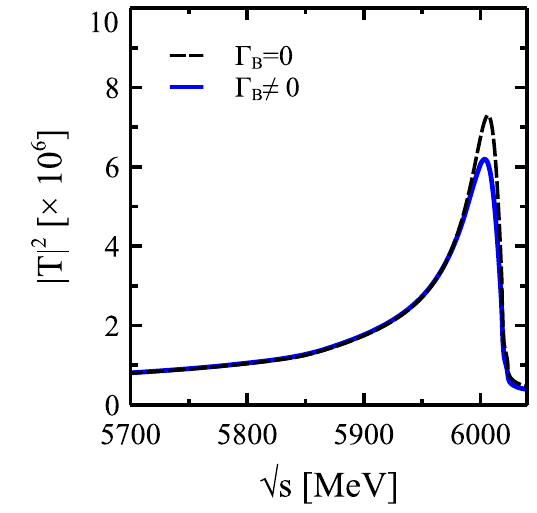
Fig. 4 Modulus squared of the three-body T -matrix as a function of √ s for J P = 0 − , q max = 450 MeV and considering the effect of the width of the